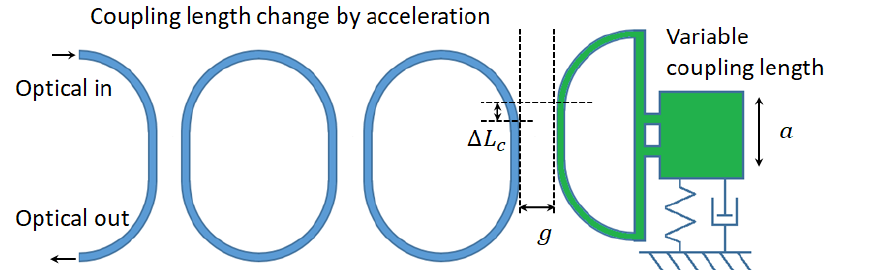
Figure 2. Accelerator construction based on coupled ring resonators (CROW) with variable length